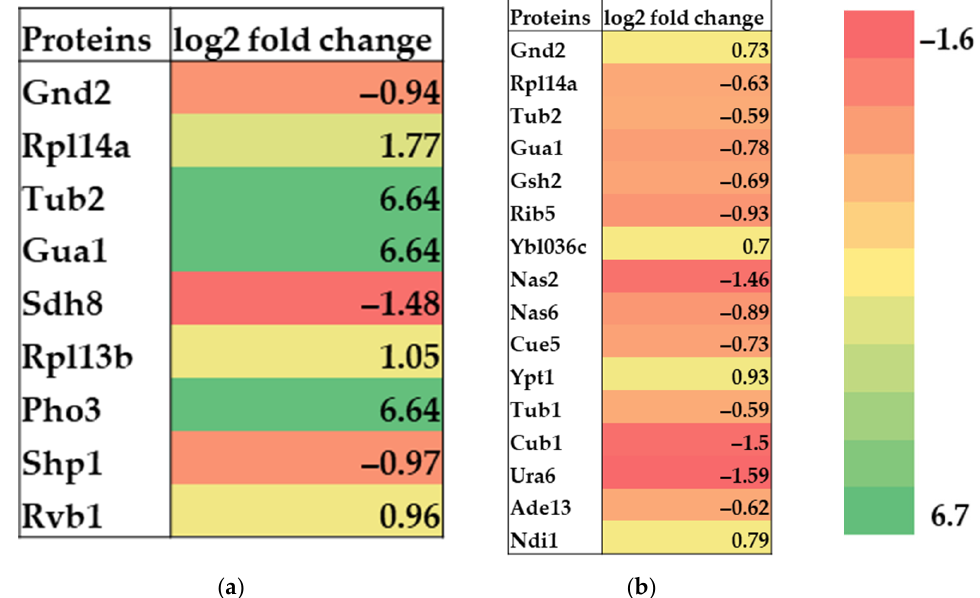
Figure 4. Heat map presenting differentially abundant proteins involved in stress response in yeast treated with fermented Spirulina extract (S) compared to yeast treated with non-fermented Spirulina extract (NF). Results are expressed as log2 fold change SV/NFV ( a ) and SE/NFE ( b ). Significantly more abundant proteins have log2 fold changes greater than 0.58, and significantly less abundant proteins have log2 fold changes lower than − 0.58; p -value ≤ 0.05.